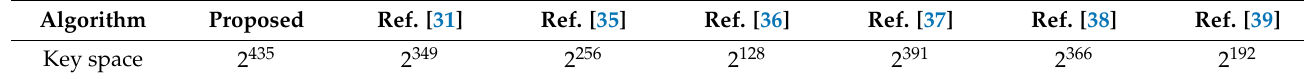
Table 3. Key space comparison.